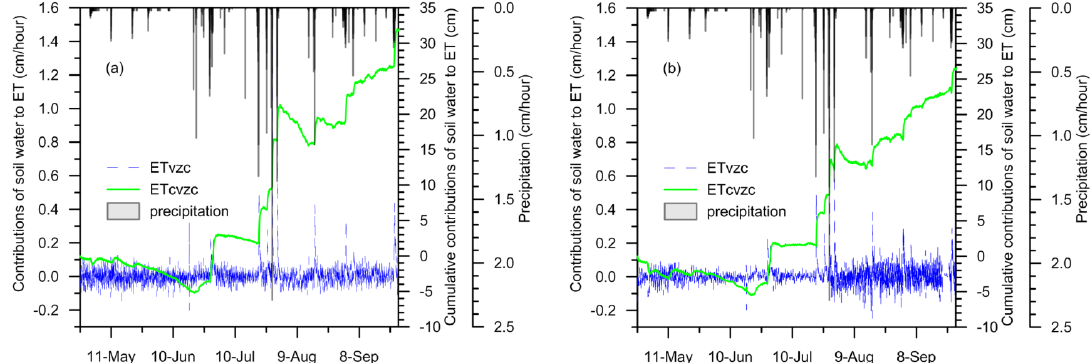
Figure 13. The contribution of soil water to ET during the simulation period ( ET vzc is the soil water contribution, and ET cvzc is the cumulative contribution): ( a ) soil water movement with heat flow; and ( b ) soil water movement without heat